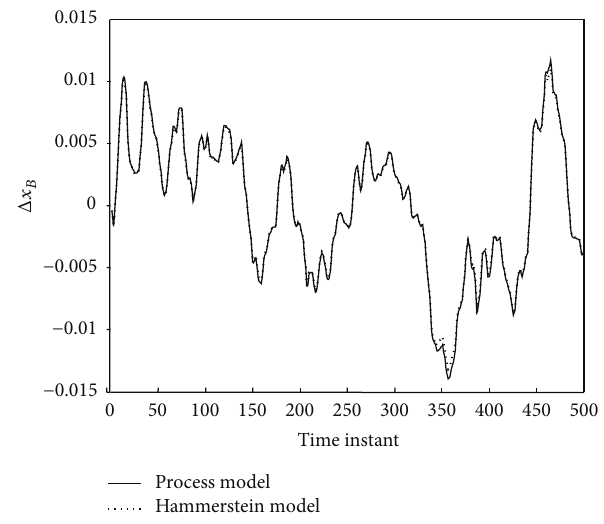
Figure 6: Comparison between the responses of second MISO Hammerstein model and process